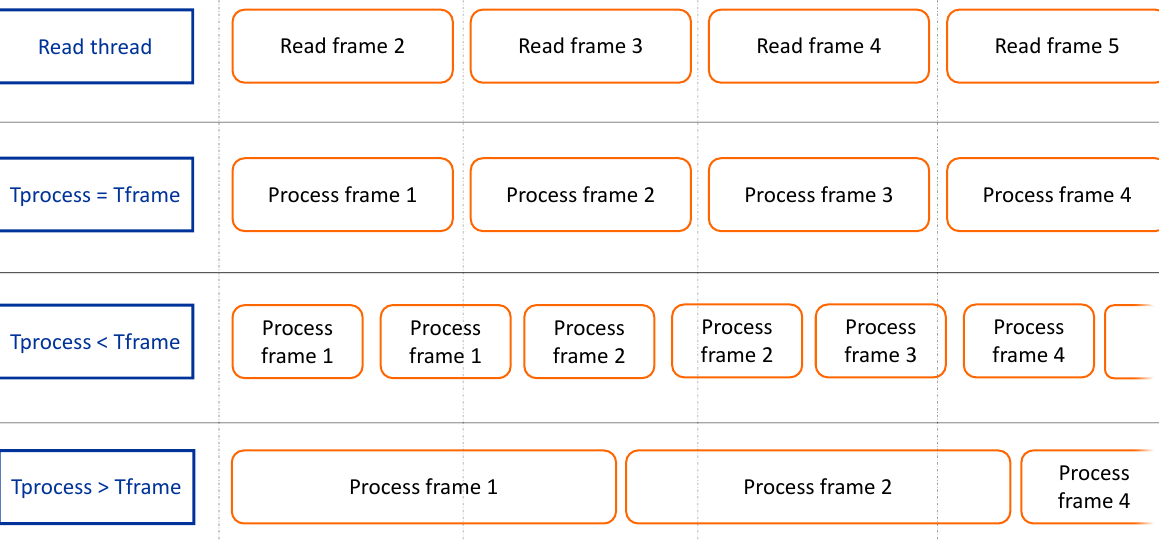
Figure 14. Processed frames for different situations, on top is the thread that reads the frames from the FPGA (stays synchronised with the FPGA), under that are three different situations where the frames are processed at the same speed ( FLR = 1), faster ( FLR < 1) or slower ( FLR > 1) than the speed they are generated by the